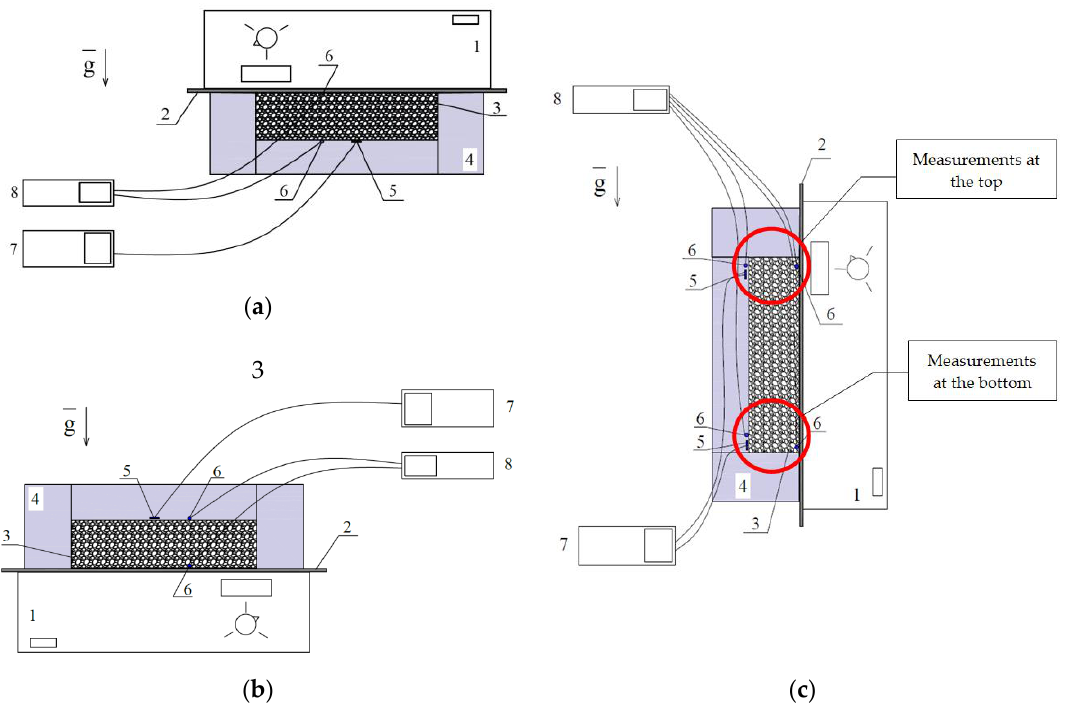
Figure 3. The schemes of the experimental stand with different positions of the heater: ( a ) from above; ( b ) from below; ( c ) from the side.